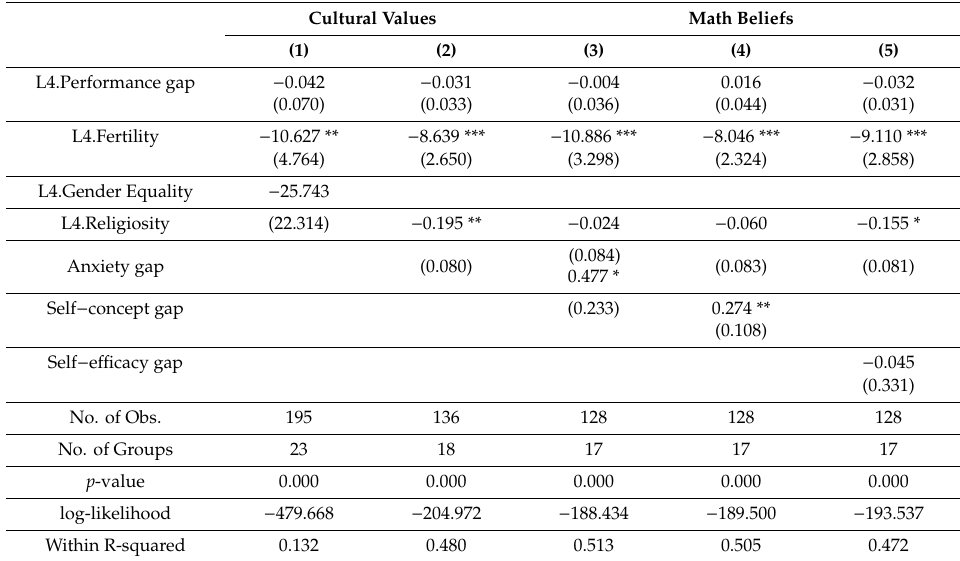
Table 2. Country-level Gender Segregation (2-digit Level Classification). Dependent variable: Dissimilarity index (2